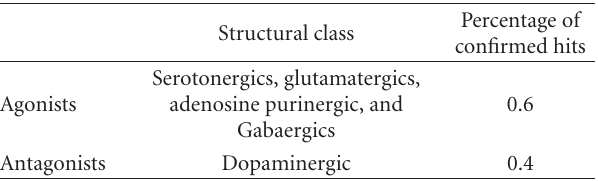
Table 3: Structural class of compounds obtained from LOPAC library screen that were confirmed in dose-response FLIPR